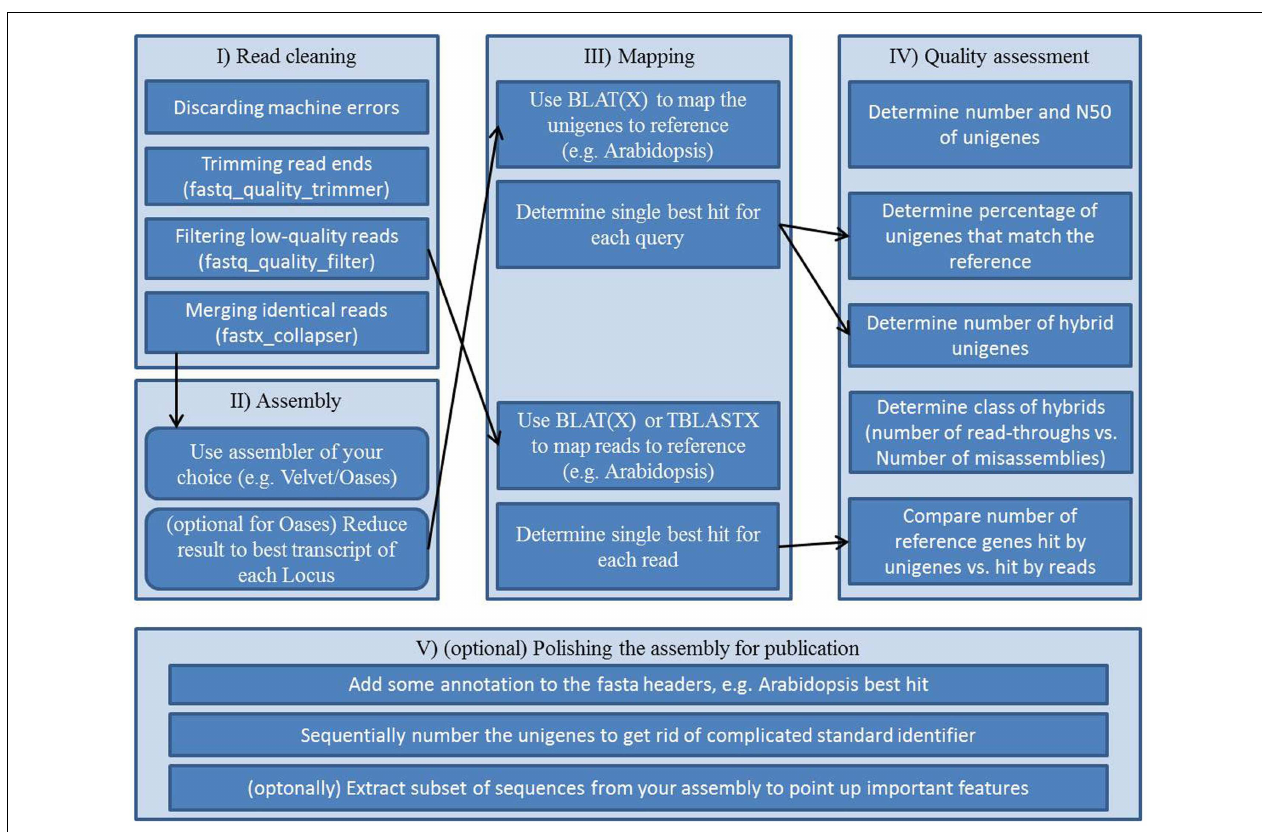
FIGURE 2 |Workflow scheme for a transcriptome assembly and quality assessment: (I) preprocessing of the raw reads, (II) assembly of processed reads, (III) mappings for annotation and for subsequent